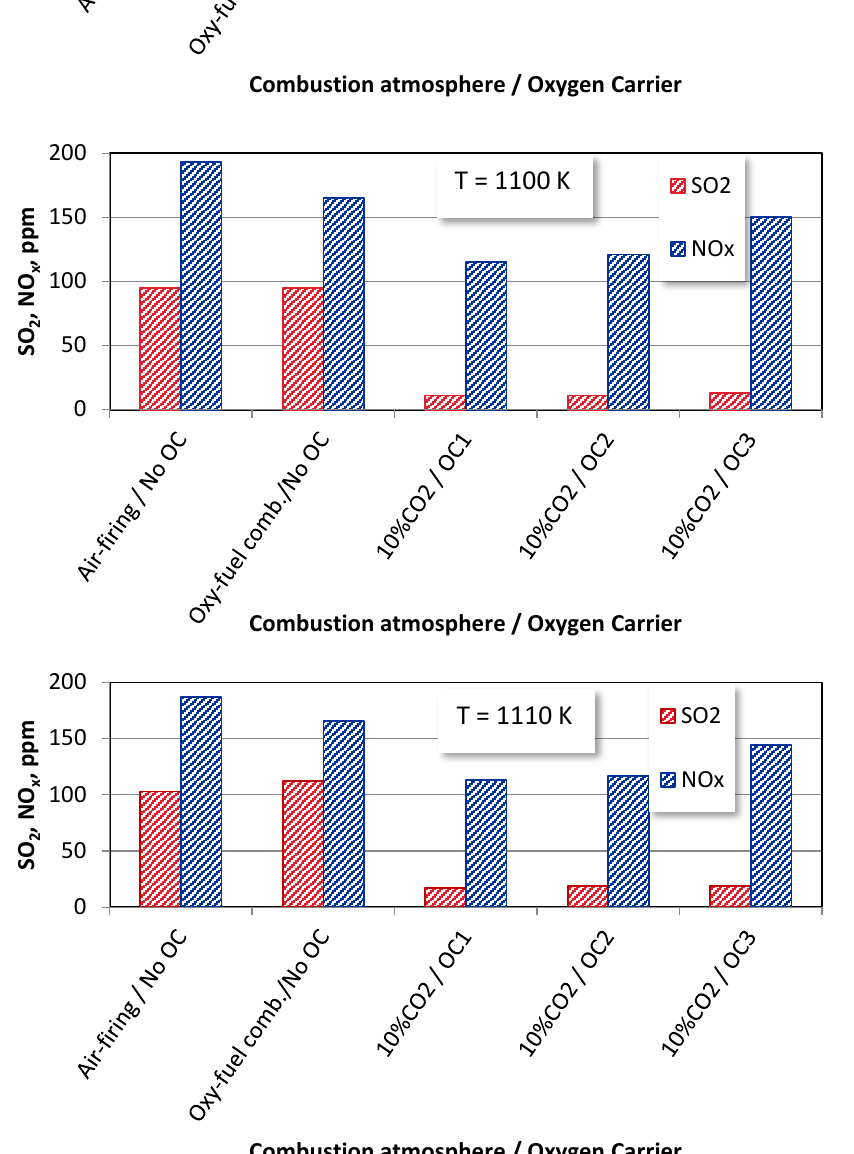
Figure 11. The effect of average fuel reactor temperature on SO 2 and NO x emissions from wood chips combustion under different combustion modes (OE = 10%).